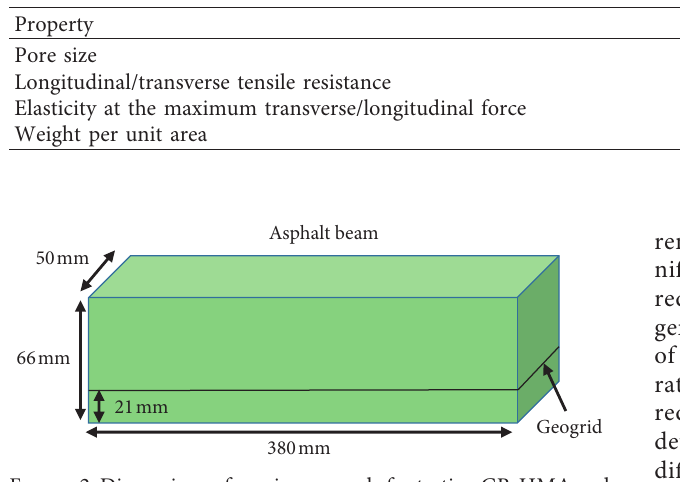
Table 4: Specifications of used geogrids.